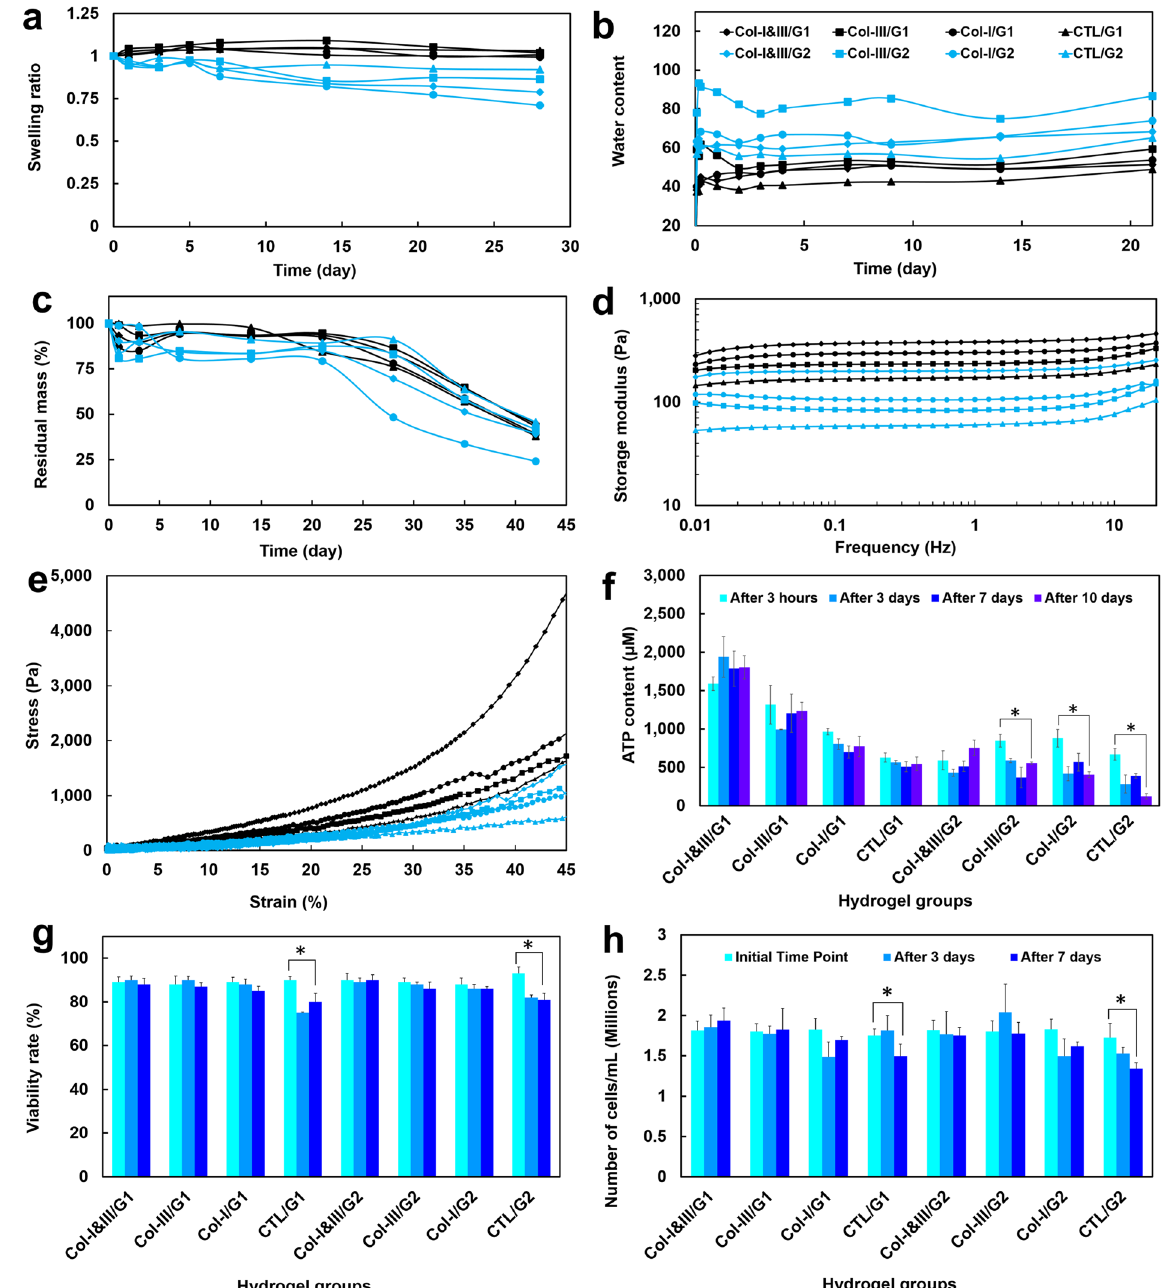
Figure 4. ( a ) Swelling kinetic of the collagen (Col)/glycol-chitosan (GCS) hydrogels initiated from the wet state. Greater swelling ratios were obtained for the Col/GCS hydrogels with higher GCS concentrations (G1s). W t and W 0 are the wet weights at the arbitrary and initial times, respectively; ( b ) Water content of the hydrogels initiated from the dried state. W t and W d are the weights at the swollen and dried states, respectively. A sudden increase was found in the water content of the hydrogels 2 hours after immersion in PBS. The hydrogels reached an equilibrium water content after 2 days; ( c ) The fractional residual mass (%) of the hydrogels immersed in the enzyme solution for a duration of 42 days. A half-life of more than 35 days was found for the proposed hydrogels; ( d ) Average storage moduli of the hydrogels for the frequencies between 0.01 and 20 Hz. Larger storage moduli were found for the Col/GCS hydrogels compared with the associated negative controls; ( e ) Stress-strain curves of the hydrogels obtained through compression test. The area inscribed below the graph denotes the compressive toughness of the sample; ( f ) The adenosine triphosphate (ATP) content of the cells over a duration of 10 days; and ( g,h ) Cell viability rates (%) and cell density (total number of cells per mL) in each hydrogel configuration over a duration of 7 days (Col-III: collagen type III, Col-I: collagen type I, Col-I&III: both Col-I and Col-III, and CTL: negative controls. G1 and G2 represent the final GCS concentration of 2% and 1%,